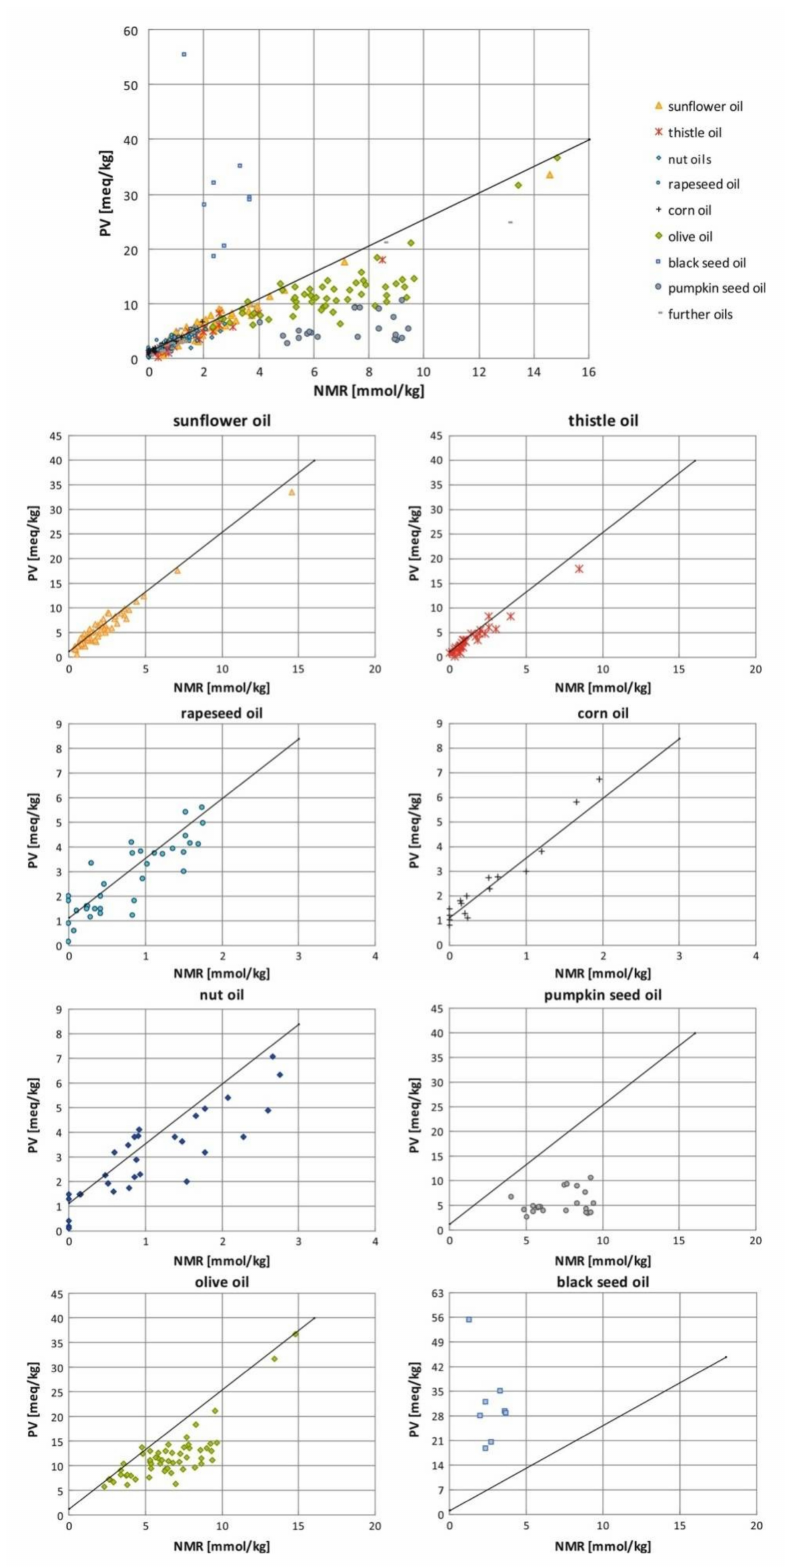
Figure 32. Plot of the PV versus the NMR-determined values of 290 oil samples. Reprinted with permission from [130]. Copyright 2012,